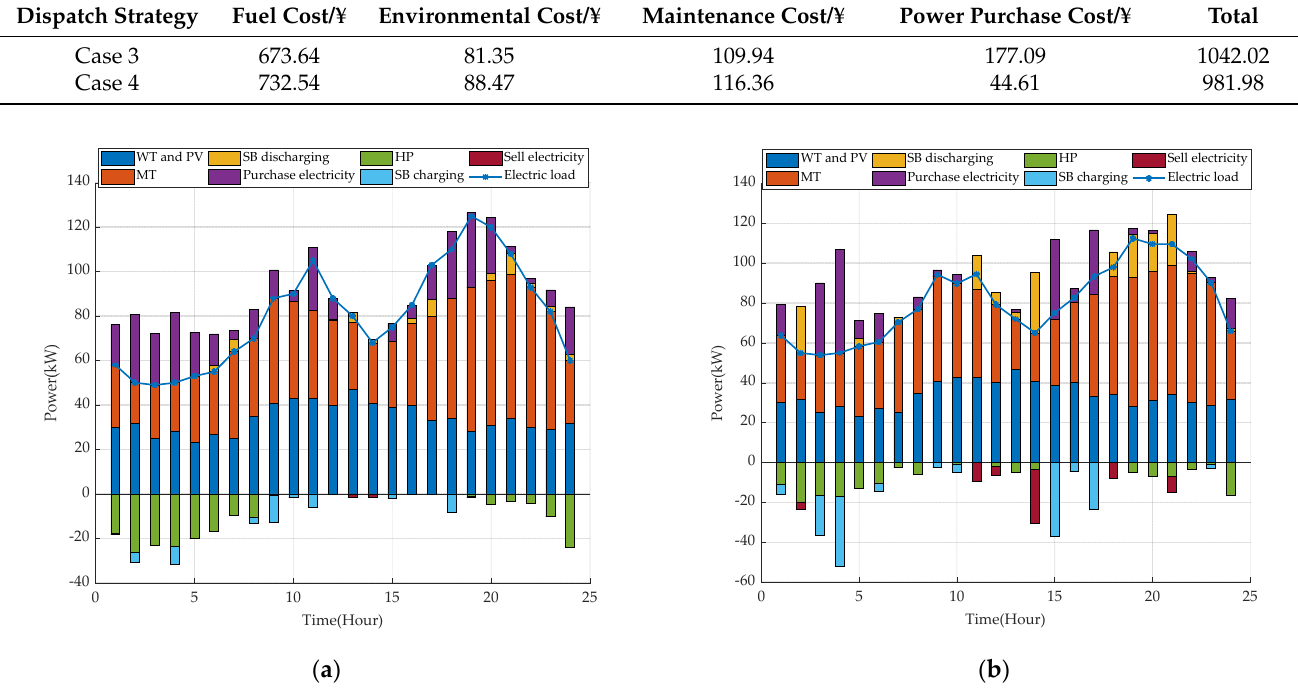
Figure 7. Economic dispatch results in winter: ( a ) Case 3 and ( b ) Case 4.